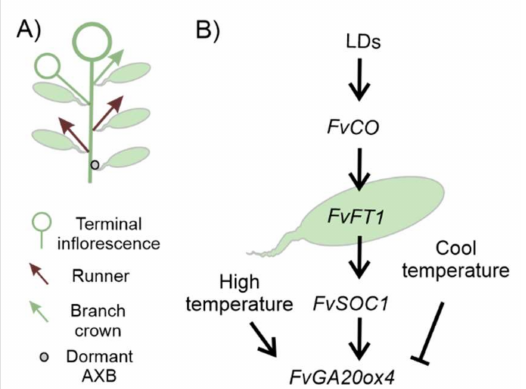
Figure 3. Strawberry growth habit and regulation of GA20ox4 expression. ( A ) Strawberry main crown; each leaf is accompanied by an axillary bud (AXB), which may remain dormant or develop into a runner or a branch crown. The uppermost branch crown below a terminal inflorescence continues plant growth in a sympodial fashion. Older branch crowns can bear their own terminal inflorescences. Each branch crown produces leaves and accompanying AXBs not shown in the figure. ( B ) Longs days (LDs) upregulate the genetic pathway leading to the upregulation of FvGA20ox4 in AXBs and resulting in runner